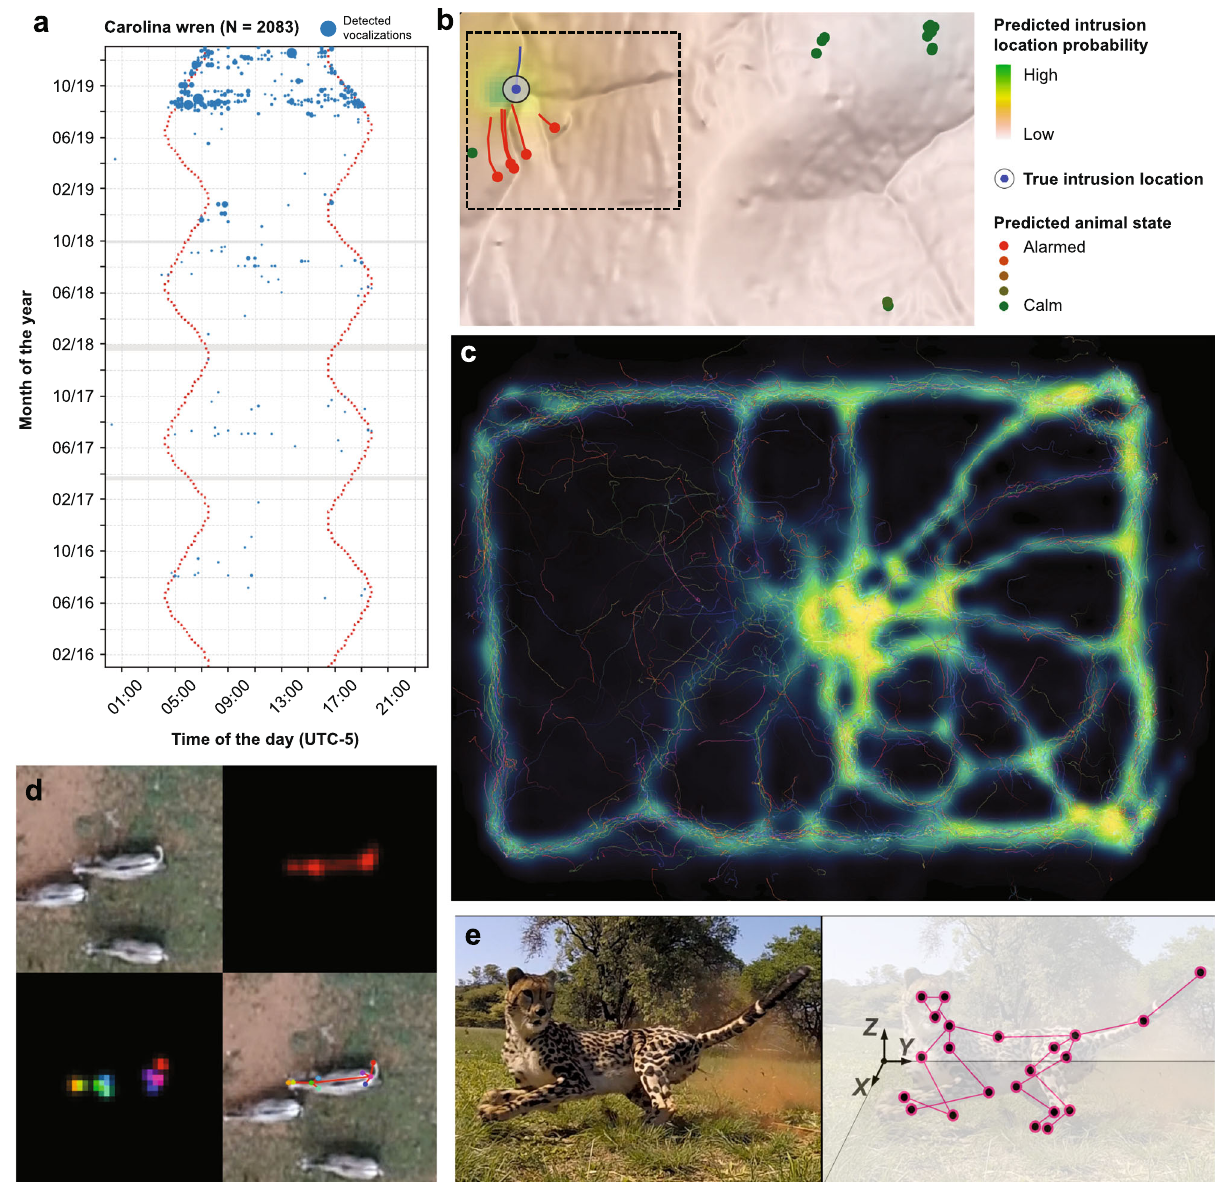
Fig. 1 Examples of research acceleration by machine learning-based systems in animal ecology. a The BirdNET algorithm 61 was used to detect Carolina wren vocalizations in more than 35,000h of passive acoustic monitoring data from Ithaca, New York, allowing researchers to document the gradual recovery of the population following a harsh winter season in 2015. b Machine-learning algorithms were used to analyze movement of savannah herbivores fi tted with bio-logging devices in order to identify human threats. The method can localize human intruders to within 500 m, suggesting `sentinel animals' may be a useful tool in the fi ght against wildlife poaching 148 . c TRex, a new image-based tracking software, can track the movement and posture of hundreds of individually-recognized animals in real-time. Here the software has been used to visualize the formation of trails in a termite colony 149 . d , e Pose estimation software, such as DeepPoseKit ( d ) 75 and DeepLabCut ( e ) 74,142 allows researchers to track the body position of individual animals from video imagery, including drone footage, and estimate 3D postures in the wild. Panels b , c , and d are reproduced under CC BY 4.0 licenses. Panels b and d are cropped versions of the originals; the legend for panel b has been rewritten and reorganized. Panel e is reproduced with permission from Joska et al. 142